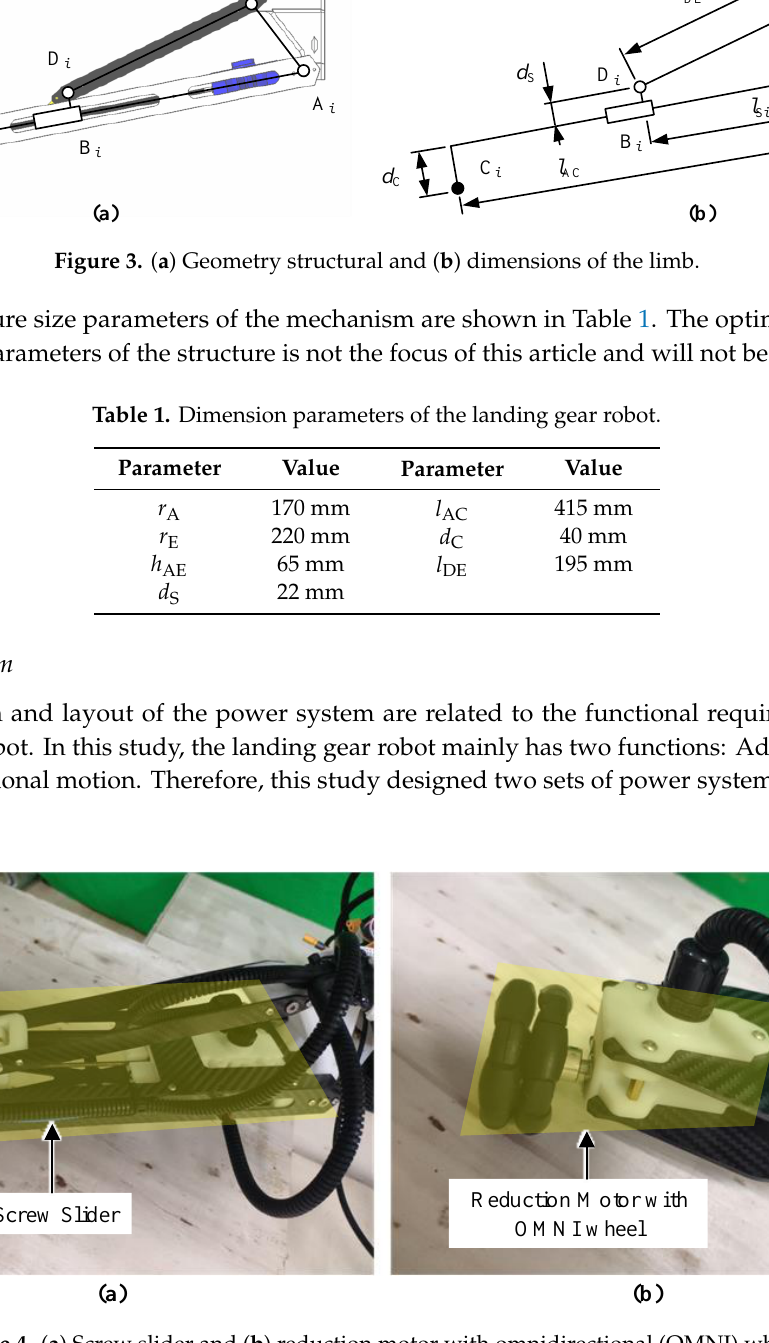
Figure 4. ( a ) Screw slider and ( b ) reduction motor with omnidirectional (OMNI) wheel.